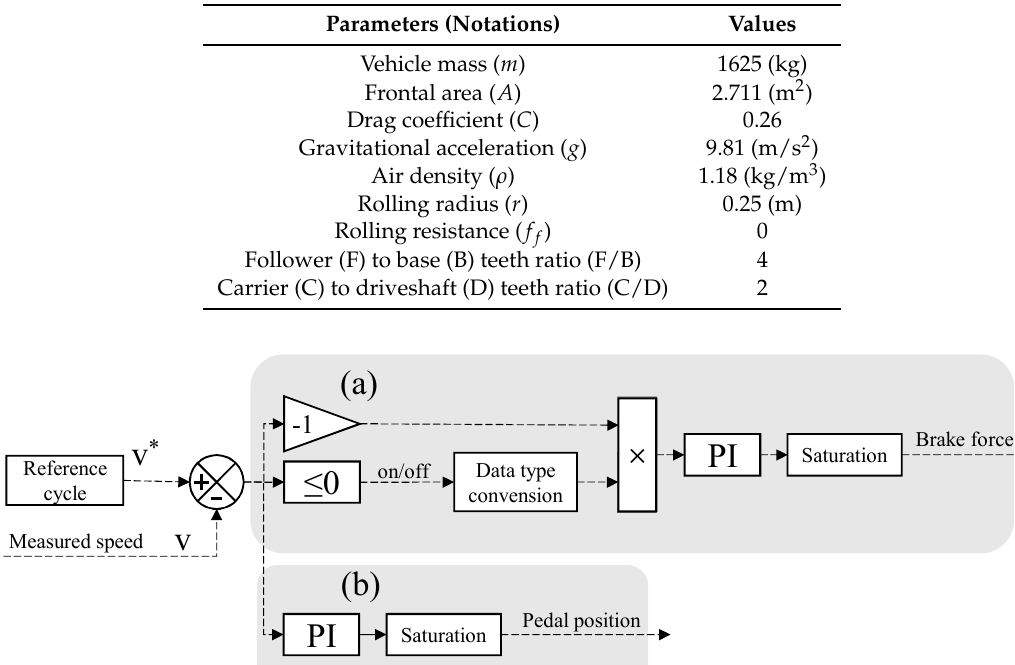
Figure 9. ( a ) Mechanical-brake-assist system control and ( b ) pedal-position